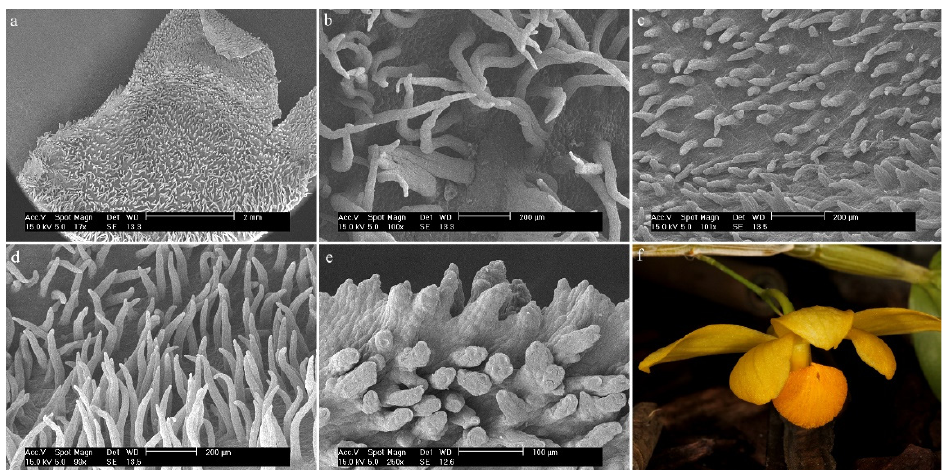
Figure 8. Dendrobium chrysocrepis C.S.P.Parish & Rchb.f. ex Hook.f.: trichomes ( a ) of the mesochile and the epichile part of the labellum; ( b ) of the final part of the hypochile of the labellum/initial part of the mesochile of the labellum; ( c ) of the mesochile part of the labellum; ( d ) of the epichile part of the labellum; ( e ) of the margin of the epichile part of the labellum; ( f ) flower (photo by John Varigos). 4.